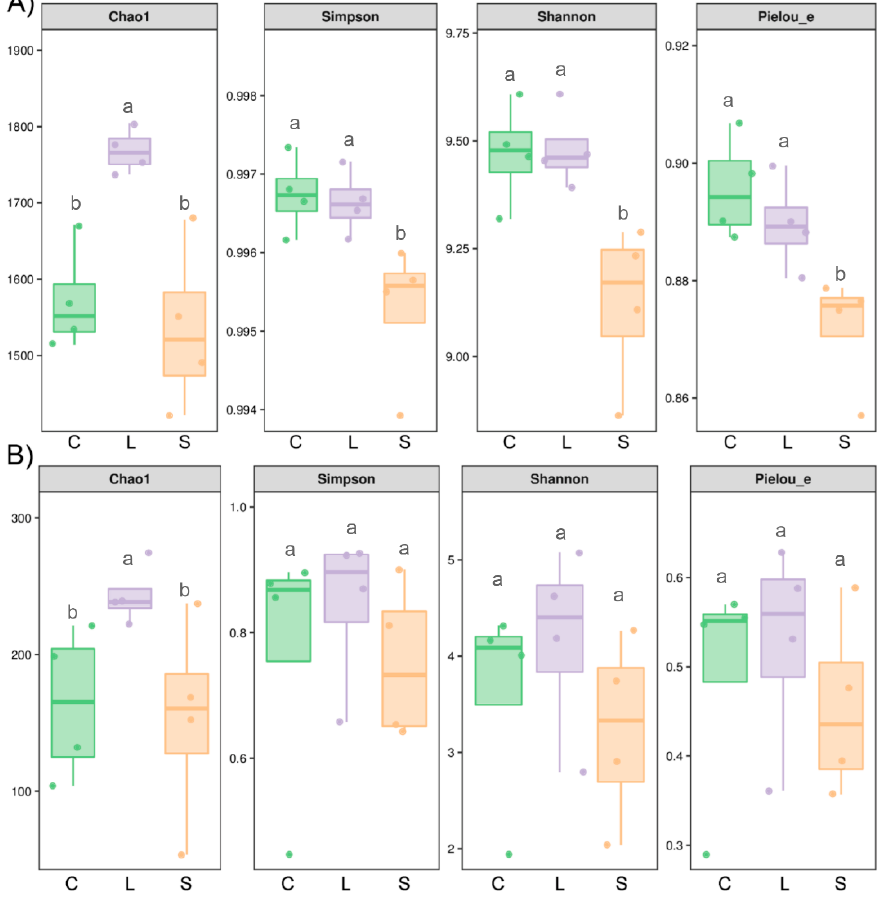
Figure 3. Soil bacterial ( A ) and fungal ( B ) diversity indices in soils with low (L) and strong (S) influence of Stropharia rugosoannulata cultivation and control (C) soils. Alpha diversity indices were based on microbial richness (Chao 1 index), diversity (Shannon and Simpson) and evenness (Pielou_e). For individual index boxes, different letters indicate significant differences at p = 0.05 (ANOVA) between means (Tukey’s HSD pairwise comparisons, n = 4).